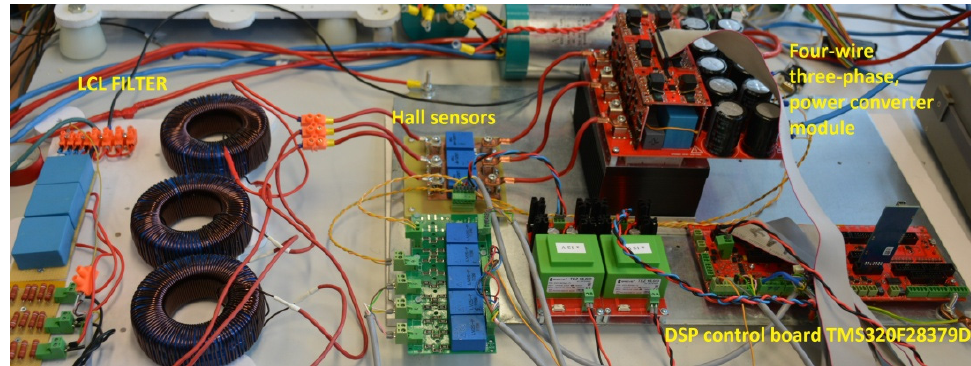
Figure 11. Experimental setup used in laboratory tests.